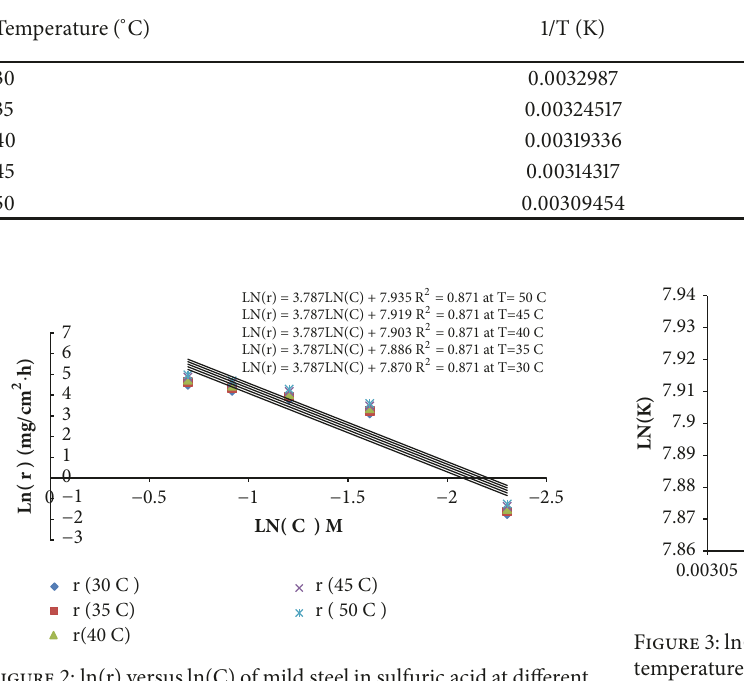
Table 4: The rate of reaction constant of mild steel in sulfuric acid at different temperature (30-50 ∘ C).